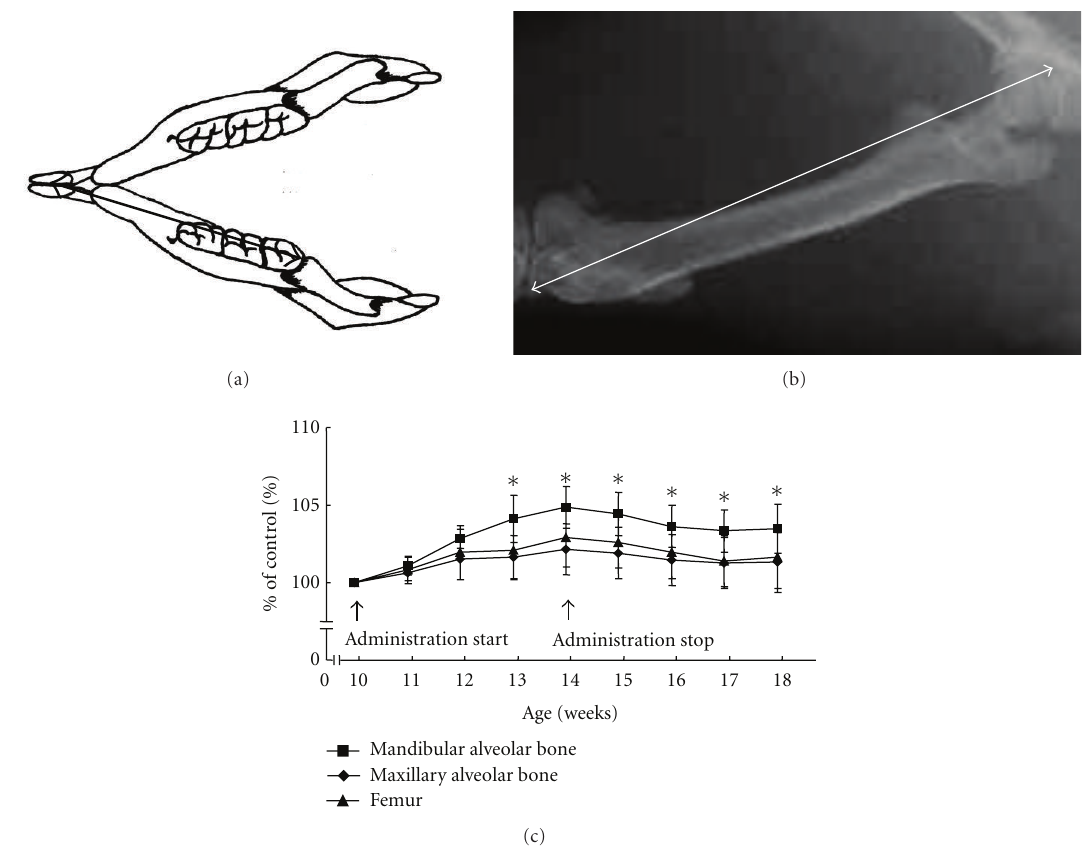
Figure 4: (a, b) Illustration showing length measurements of the mandibular alveolar bone (a) and femur (b). Measurement of the maxillary alveolar bone (not shown) was the same as for the mandible. (c) Bone length during and after administration of human IGF-I, shown as a percentage of bone length in the control group at the same time ( ∗ P < 0 . 05, mandibular alveolar bone versus other bones). Data represent the mean ± SD of six rats, adapted from a previous report